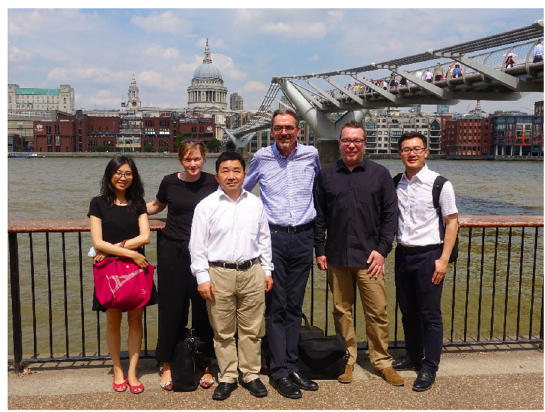
Fig. 17 Design Ecologies Research Team,